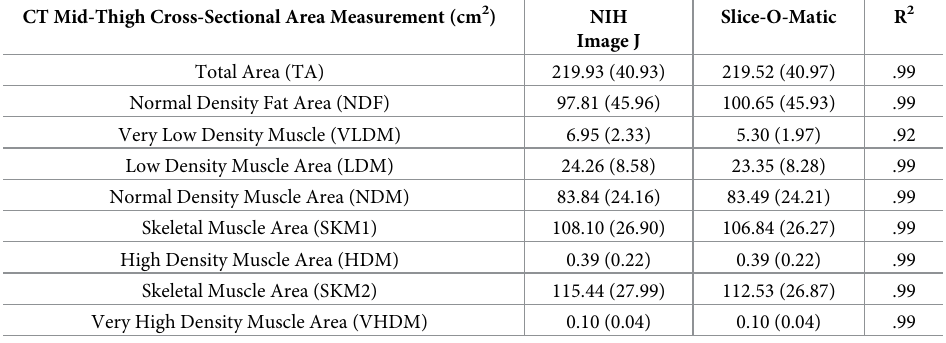
Table 3. Mean (SD) CT cross-sectional area measurements between NIH Image J and Slice-O-Matic software using current methods.